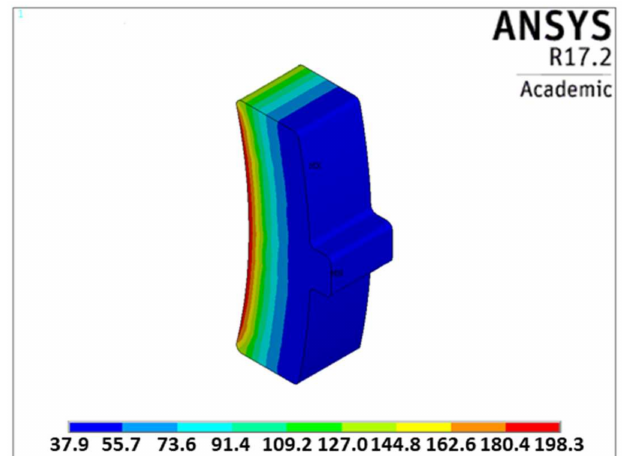
Figure 7. Braking maneuver B—Temperature of the brake block at the end of the brake maneuver.